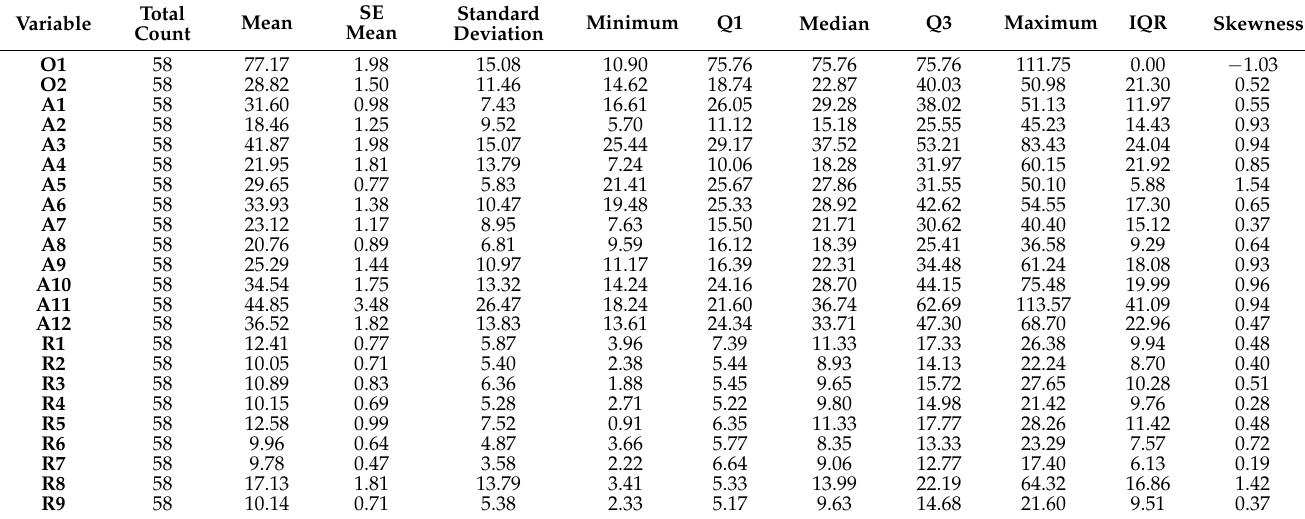
Table A5. Statistical summary of the reported EUI